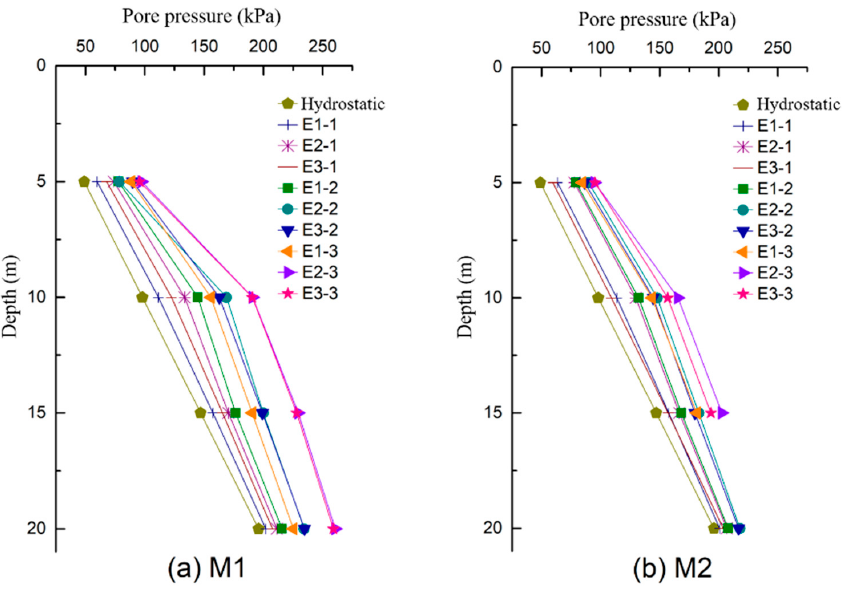
Figure 6. Maximum excess pore pressure along the depth: ( a ) medium dense model, M1; ( b ) dense model, M2.